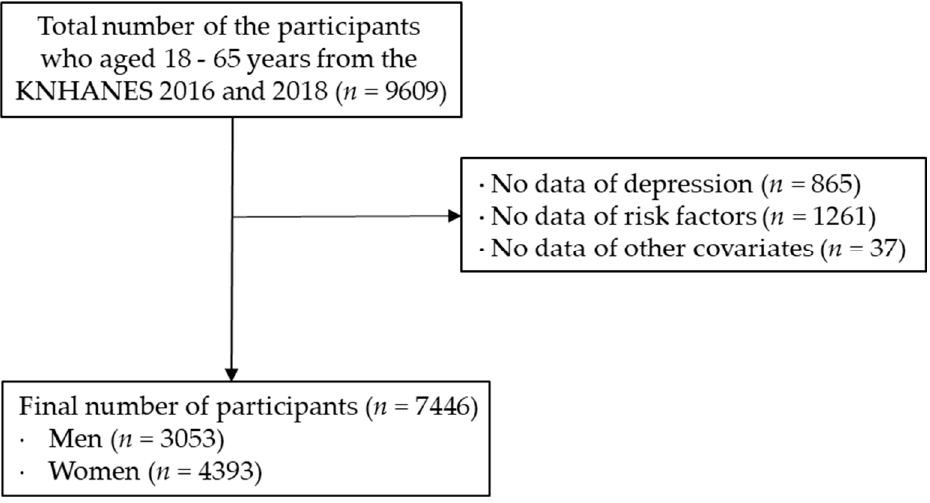
Figure 1. Flow chart of selection for study participants.